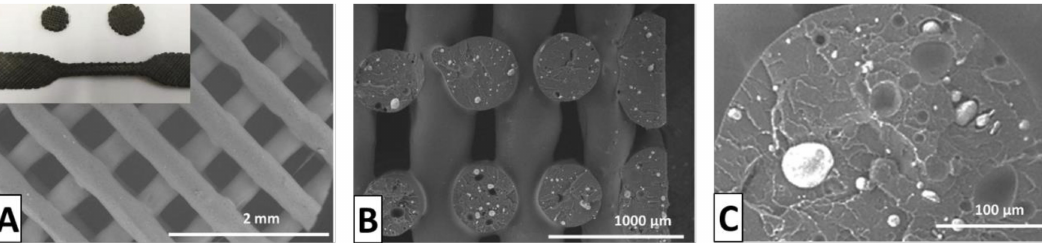
Figure 6. Compatibilized magnesium nanoparticle PLA filaments. ( A ) Fused deposition modelling (FDM) 3D-printed sca ff old, ( B ) layer structure of sca ff old, ( C ) cross section of individual layer showing magnesium dispersion. Reproduced with permission from [53], Elsevier,